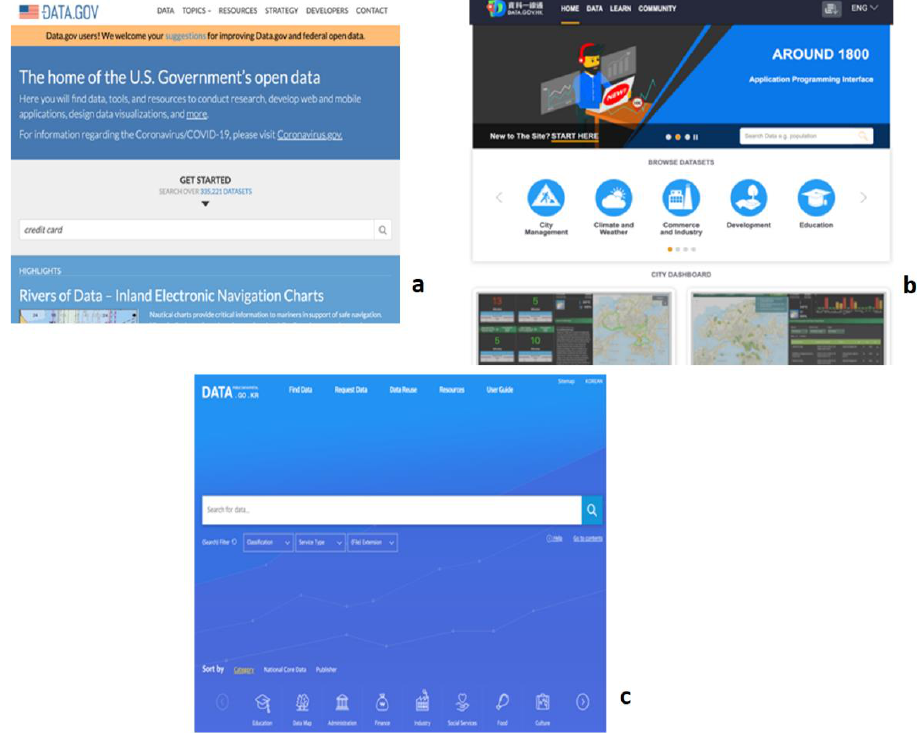
Figure 2. Examples of government open-data portals: ( a ) the U.S. government data portal; ( b ) Hong Kong’s Public Sector Information portal; ( c ) South Korea’s public data portal [58 – 60].